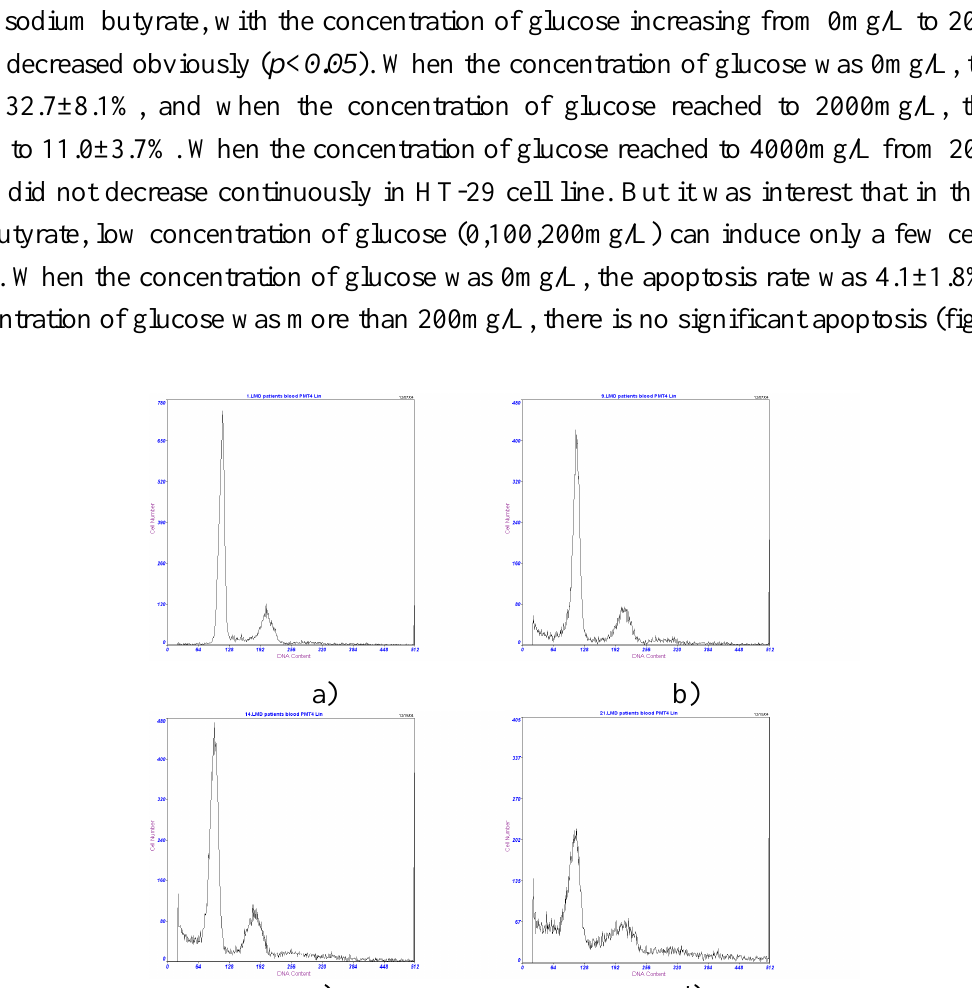
Figure 3. When HT-29 cell line was treated with 5 mmol/L sodium butyrate (containing 2000mg/Lglucose ) for 48 h, the expression of Bax didn’t change obviously, but the expression of Bcl- x/l decreased obviously compared with that without treating with sodium butyrate (containing 2000mg/Lglucose ). When HT-29 cell line was treated with 5 mmol/L sodium butyrate for 48 h, with the concentration of glucose increased from 0mg/L to 500,2000mg/L,the expression of Bcl-x/l protein increased obviously, but the expression of bax protein didn’t change. After treatment with sodium butyrate more than 24 h, the apoptosis in HT-29 cells can be observed and sodium butyrate induced apoptosis in a time-depended manner.(data not show). When treated